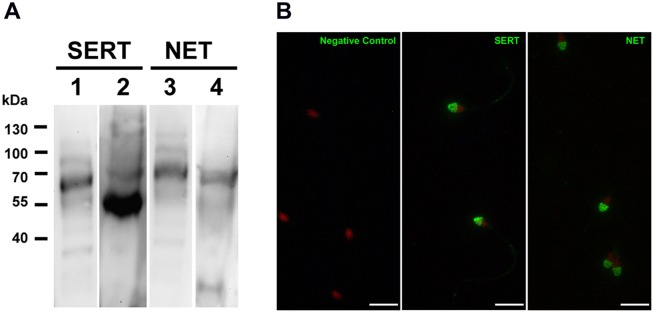
SERT and NET are present in ejaculated sperm. The presence and location of other monoamine transporters was determined in equine sperm.A) The presence of SERT and NET transporters were verified in equine sperm (line 2 and 4) by Western blot assays. A protein extract from whole rat brain (line 1 and 3) was used as a control. Images are representative of 3 independent experiments. B) The localization of SERT and NET was performed by indirect immunofluorescence assays. Images are representative of 3 independent experiments. Bar scale is 10 µm.